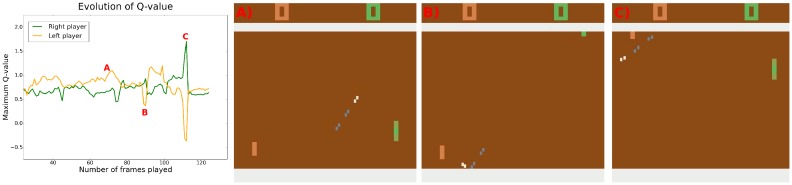
A competitive game—game situations and the Q-values predicted by the agents.A) The left player predicts that the right player will not reach the ball as it is rapidly moving upwards. B) A change in the direction of the ball causes the left player’s reward expectation to drop. C) Players understand that the ball will inevitably go out of the play. See supporting information for videos illustrating other game situations and the corresponding agents’ Q-values.